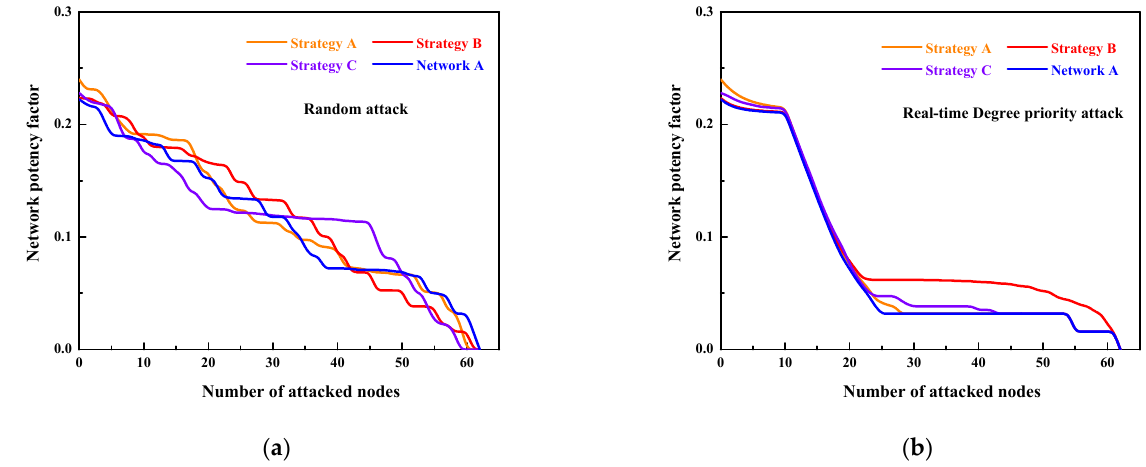
Figure 10. Graph of rate of change of efficiency under two attacks. ( a ) Random attack; ( b ) Deliberate attack.